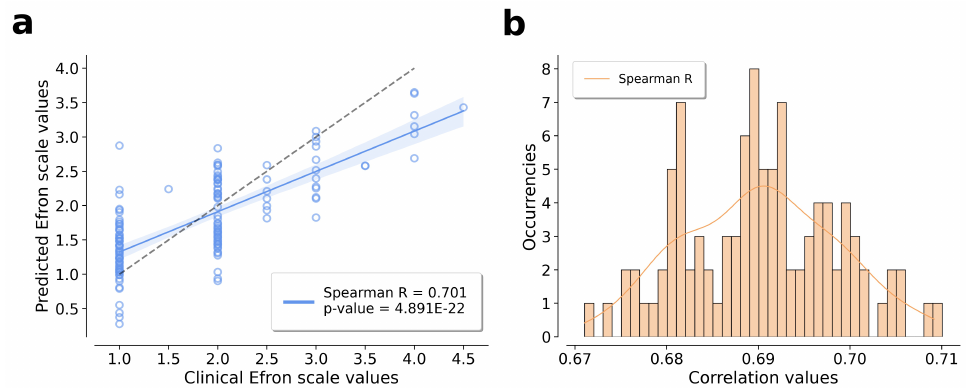
Figure 4. Results of the regression model for the prediction of the Efron scale values, developed starting from the set of features extracted. The correlation between the ground truth and the predicted values is estimated using the Spearman’s rank correlation coefficient (ref. plot legend); ( a ) results of a single cross validation of the model. We highlight with the dashed line the axes bisector that corresponds to a perfect prediction. Despite the significance of the correlation found, the model finds many difficulties with low Efron scale values. We note that the predictions are performed on a set of data completely independent to the training set; ( b ) results obtained by the same pipeline on 100 different cross validations. In each iteration, a different 10-fold cross validation was applied for the estimation of the Spearman’s rank correlation coefficients. The average Spearman’s rank coefficient found is 0.69 with a standard deviation of 0.008.